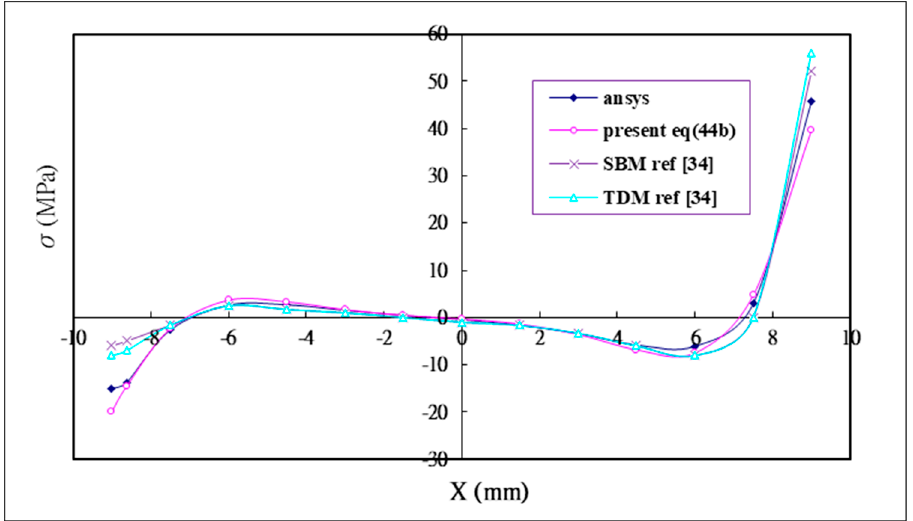
Figure 6. Analytical solution Equation (44b) of the peel stress in the adhesive compared with the numerical solutions using finite element software ANSYS and Wu [34].